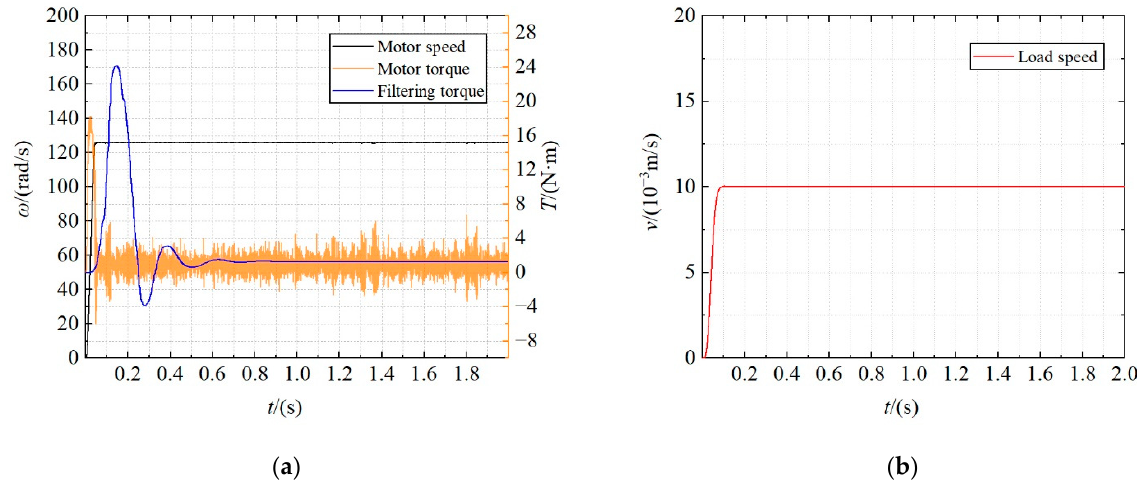
Figure 20. ( a ) The motor speed and torque of ETD; ( b ) the load speed of ETD.